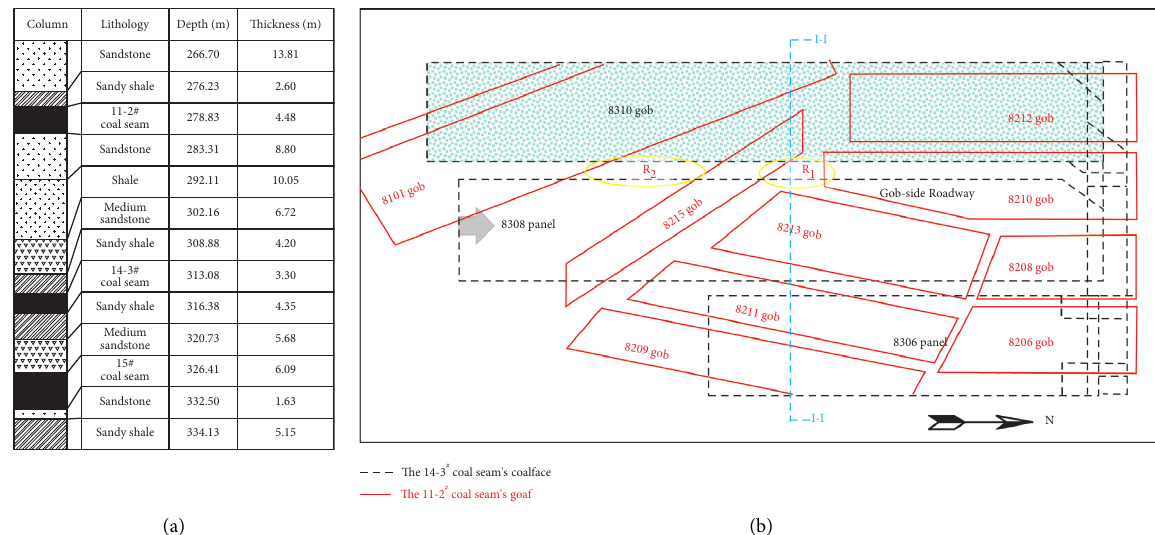
Figure. 2: (a) Comprehensive column illustration of coal and rock layers in the 8308 panel. (b) Comparison of the 8308 panel and 11–2# coal seam goaf area.